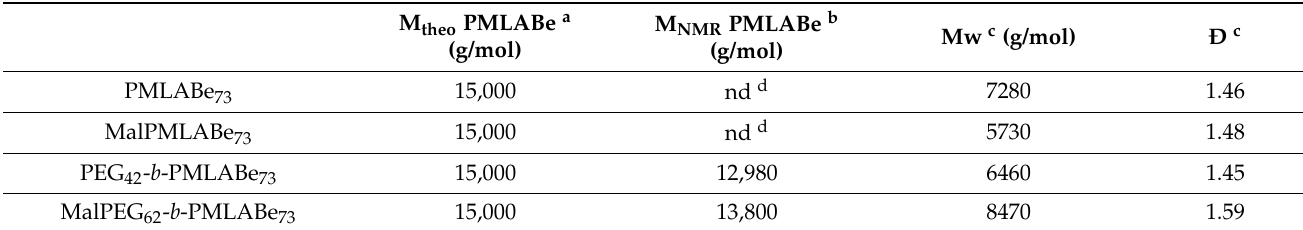
Table 3. Molar masses of PMLABe blocks calculated from 1 H NMR spectra and of synthesized (co)polymers measured by SEC in